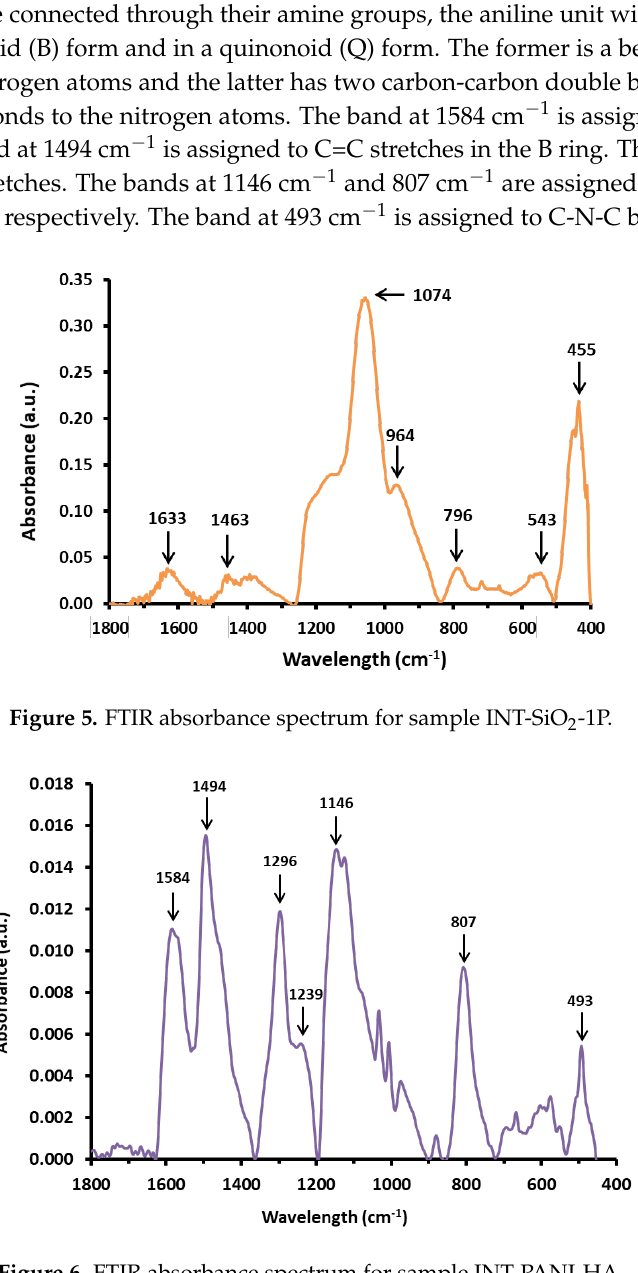
Figure 6. FTIR absorbance spectrum for sample INT-PANI-HA.